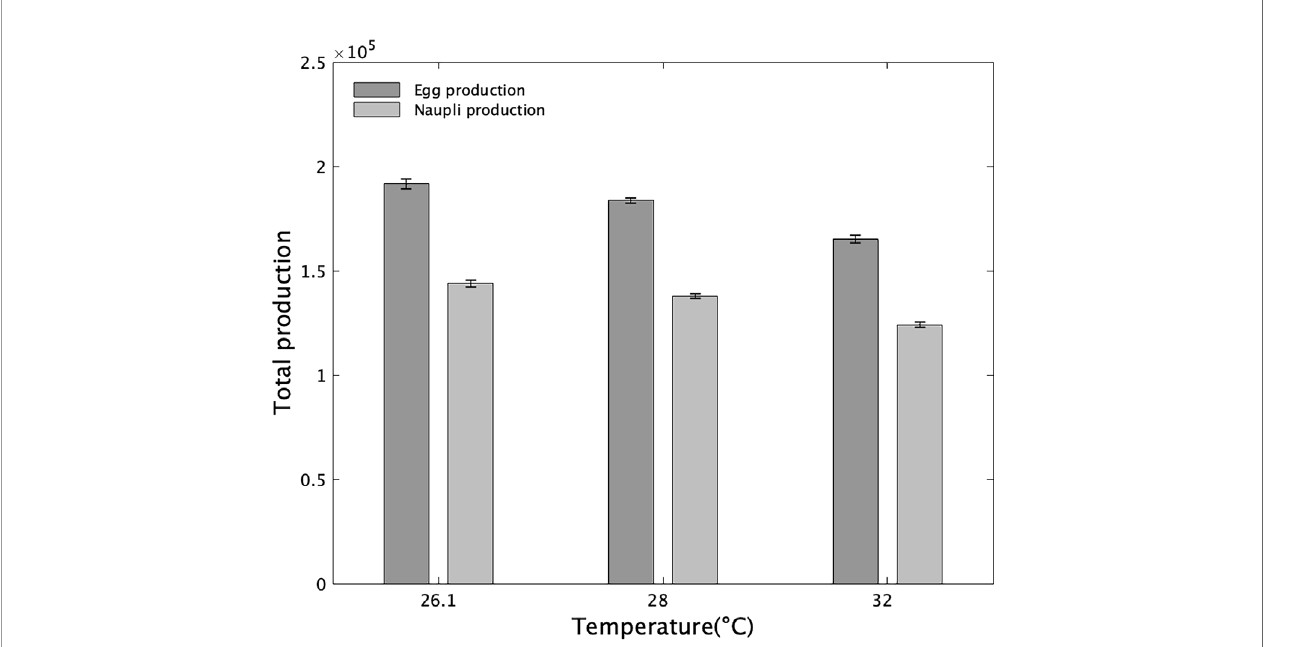
FIGURE 9 | Cumulated total egg and nauplii production of 1000 females over a period of 20 days at three constant temperatures. Salinity was fi xed at 21 PSU. Vertical bars represent the mean values over fi fteen replicates and the error bars represent the standard